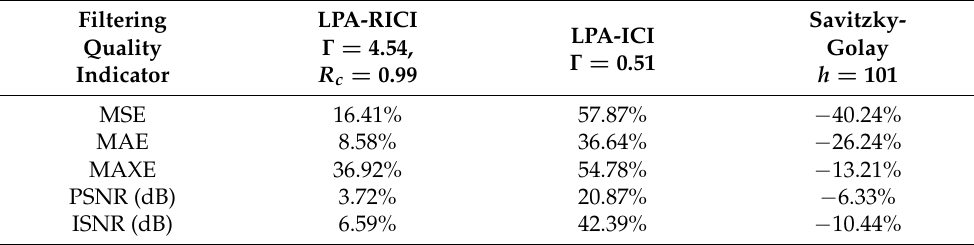
Table 26. HeaviSine signal (SNR = 7 dB)—Filtering quality improvement of the RBF-RICI-based filtering over other tested